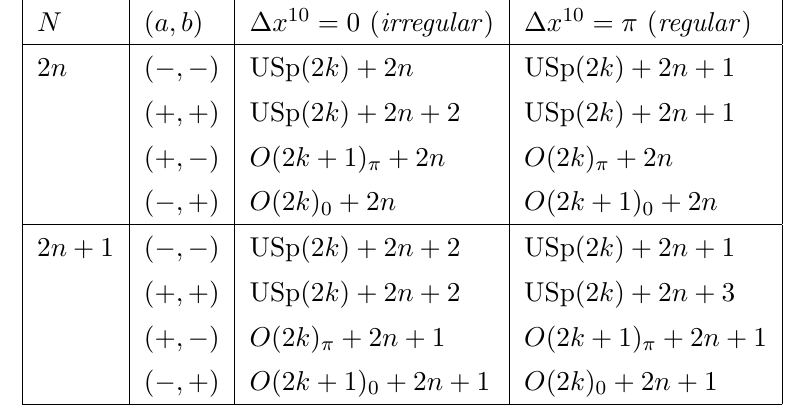
Figure 8 . M-brane con(cid:12)gurations with an odd number of (cid:13)avor branes for O ( K ) and USp(2 k ) theories. For b = + a single M2-brane may be suspended between the M5 and the unpaired f M5 (blue line).